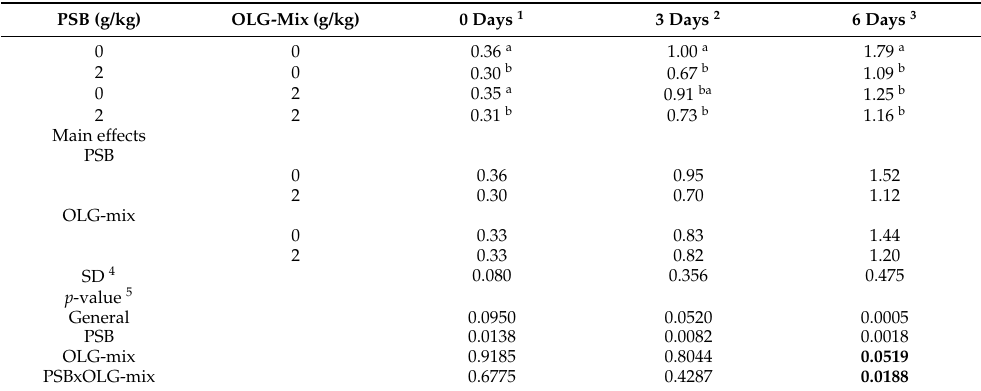
Table 6. Effects of protected sodium butyrate (PSB) and olive leaf and grape-based by-product (OLG-mix), and their interaction on the oxidative stability of meat (mg MDA/kg of sample) at 0, 3, and 6 days of refrigerated storage (4 ◦ C).